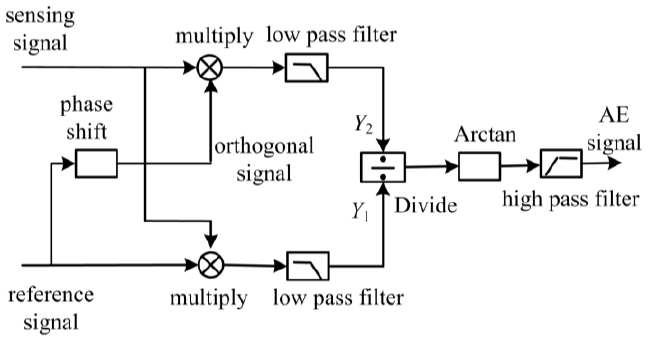
Figure 6. Arctangent demodulation theory.